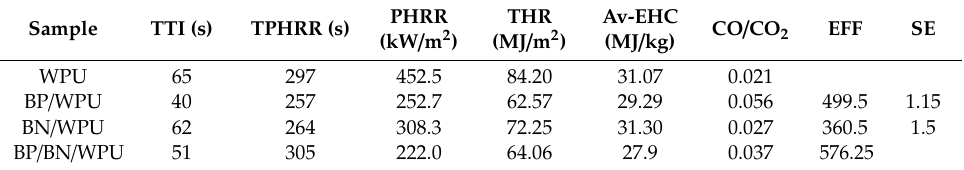
Figure 4. Cone calorimeter test of the samples: ( a ) HRR curves; ( b ) THR curves; ( c ) CO 2 release curves; ( d ) CO release curves. Table 2. The cone calorimeter test data of WPU, G/WPU, and BP/G/WPU.